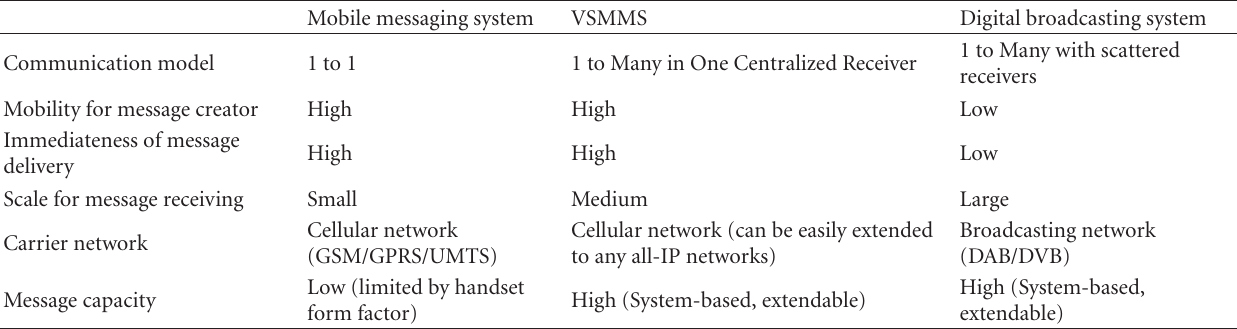
Table 2: Comparisons of the contemporary messaging communication systems and VSMMS